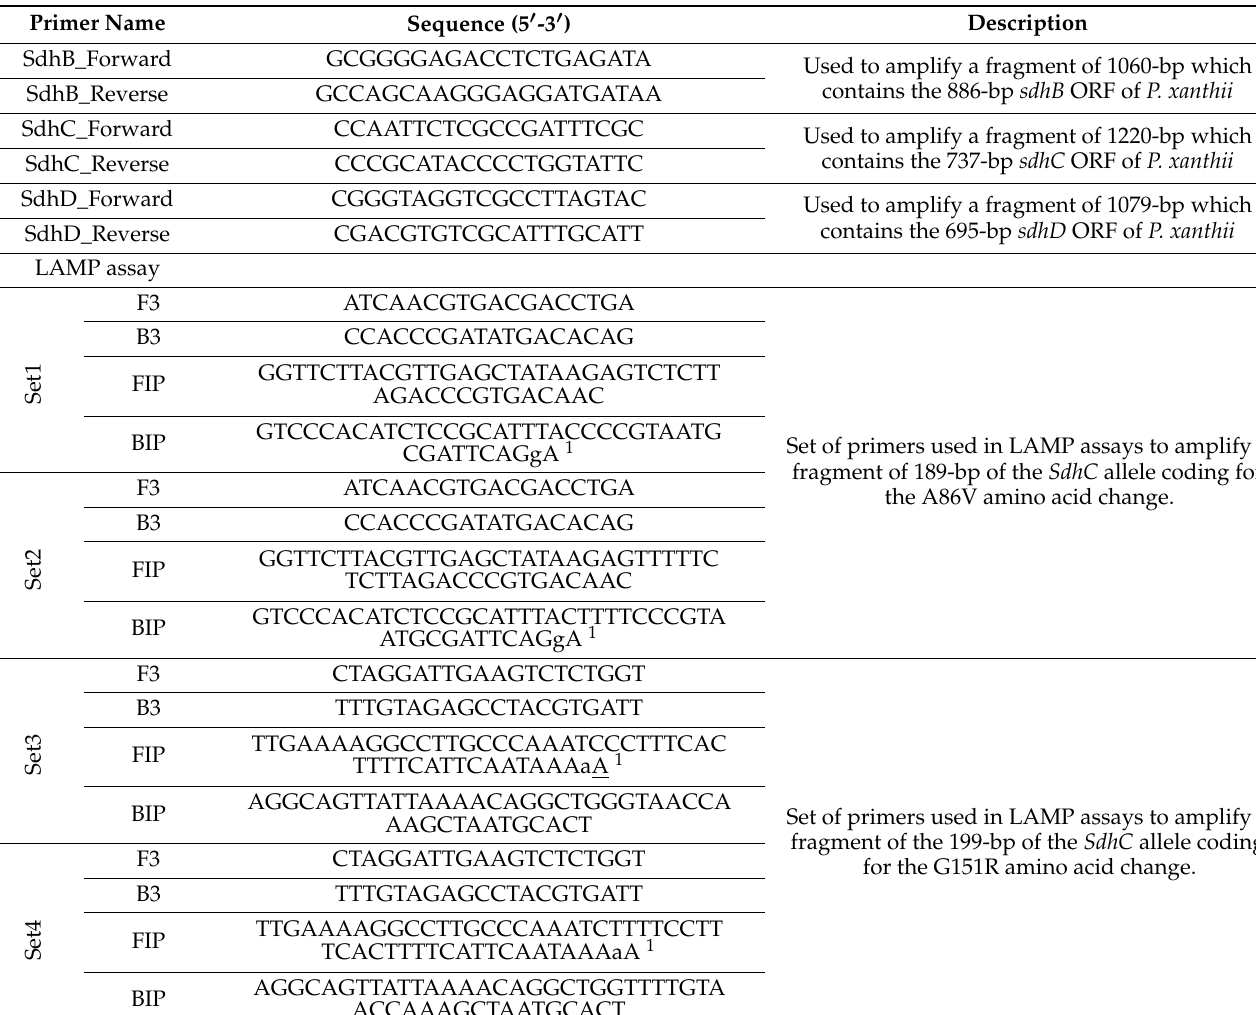
Table 2. Primers used in this